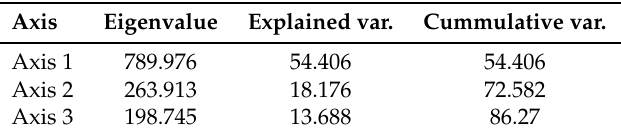
Table 2. Eigenvalues and explained variance.